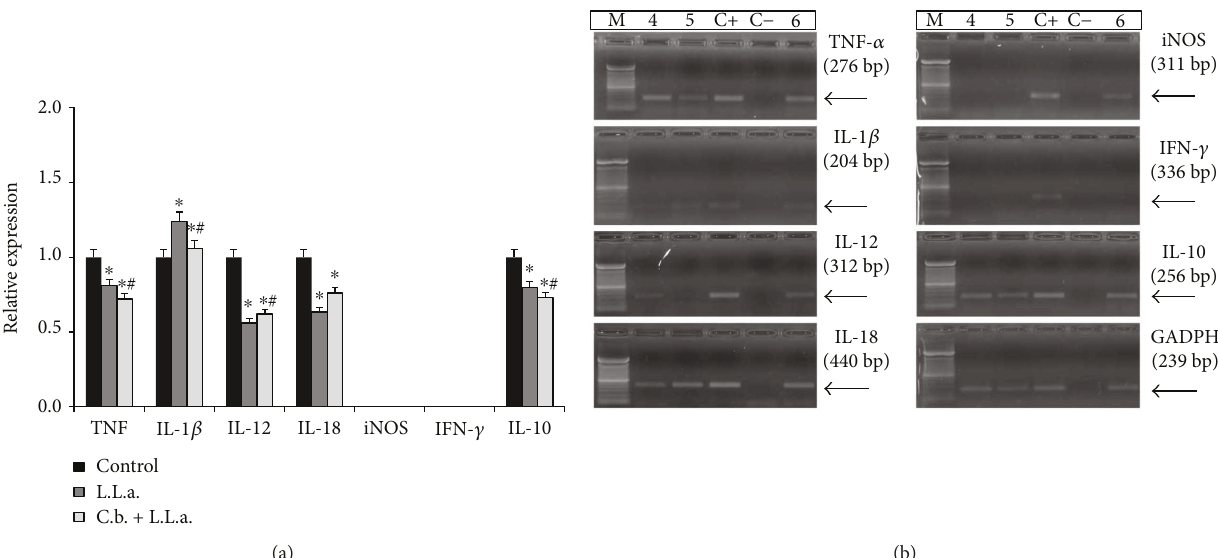
Figure 4: Expression levels of cytokine and iNOS mRNA by macrophages treated with hydroalcoholic extract of C. brasiliense and infected with Leishmania ( L. ) amazonensis . (a) L.L.a.: L. ( L. ) amazonensis ; C.b.: C. brasiliense . Peritoneal macrophages from BALB/c mice were treated with hydroalcoholic extract of C. brasiliense (30 μ g/mL) for 3h and infected with promastigotes of L. ( L. ) amazonensis (10 parasites :1 macrophage) by more than 3 h. Macrophages were only infected with promastigotes of L. ( L. ) amazonensis (10 :1) and untreated. As a negative control, macrophages were incubated only with RPMI for 6h. ∗ p < 0 05 signi fi cantly compared to negative control; # p < 0 05 compared to infected and untreated macrophages. (b) Cytokine mRNA expression by semiquantitative reverse transcriptase-polymerase chain reaction (RT-PCR) DNA fragments was separated in 1.5% agarose gel electrophoresis and revealed with ethidium bromide in a transilluminator. M: molecular marker; C − : ampli fi cation negative control (H O); C+: DNA obtained from macrophages stimulated 2